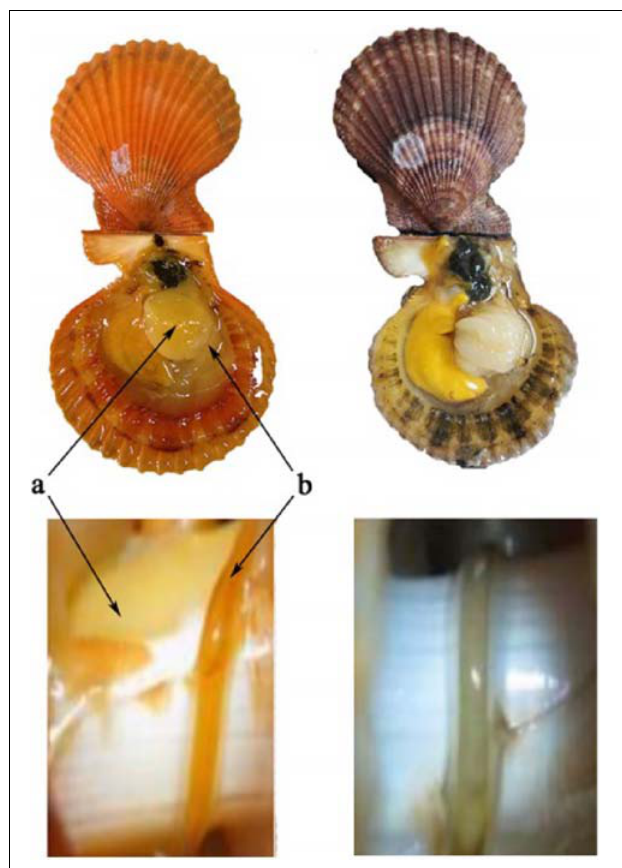
FIGURE 1 | Golden and brown noble scallops and their guts. The golden scallop with golden shell, golden adductor and golden gut (left, named as GG), and the brown scallop with orange shell, white adductor and white gut (right, named as BW). Two kinds of tissues: adductor (a) and gut (b).